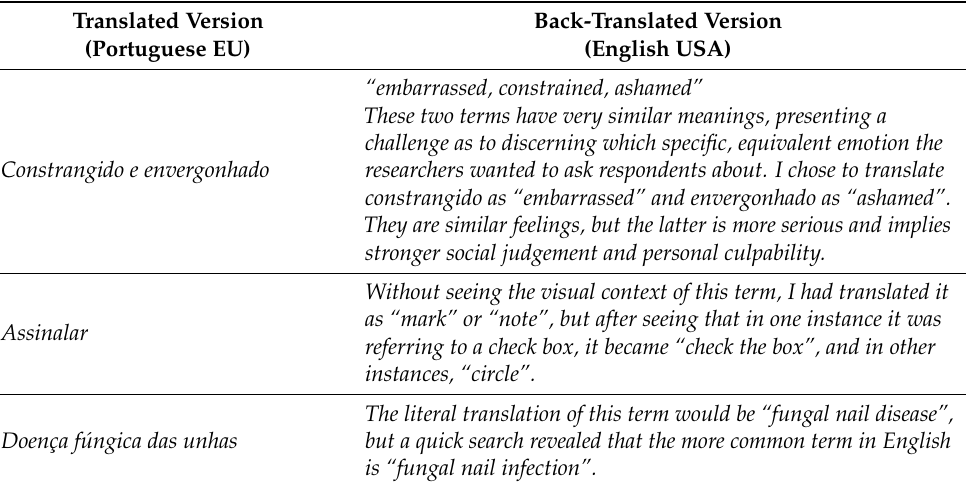
Table 4. The translated version and back-translated version of the OnyCOE-t TM .